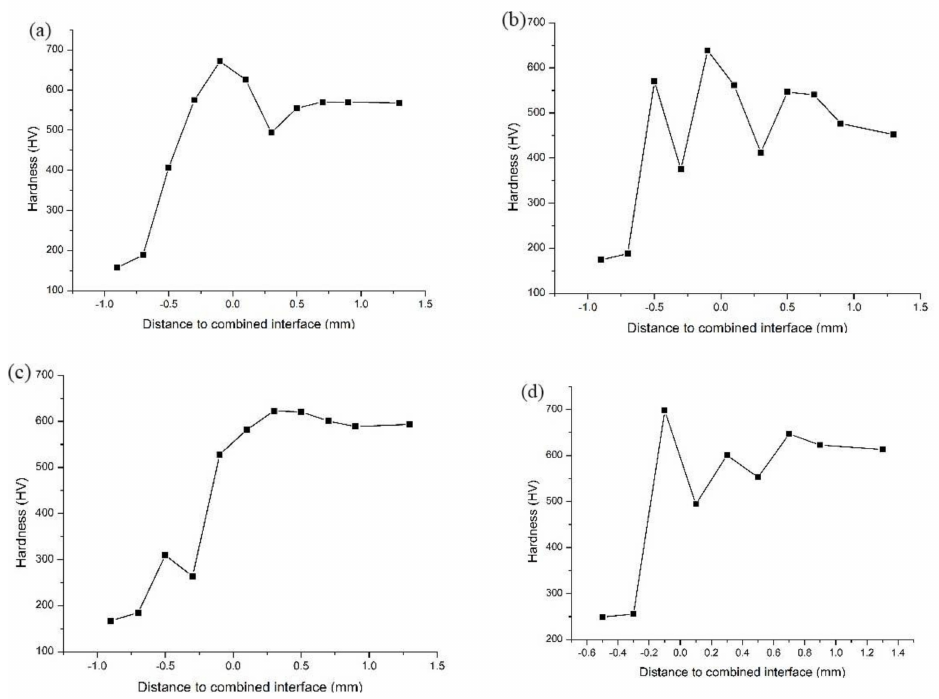
Figure 11. Trend of Vickers hardness. ( a ) Sample 1; ( b ) sample 2; ( c ) sample 3; ( d ) sample